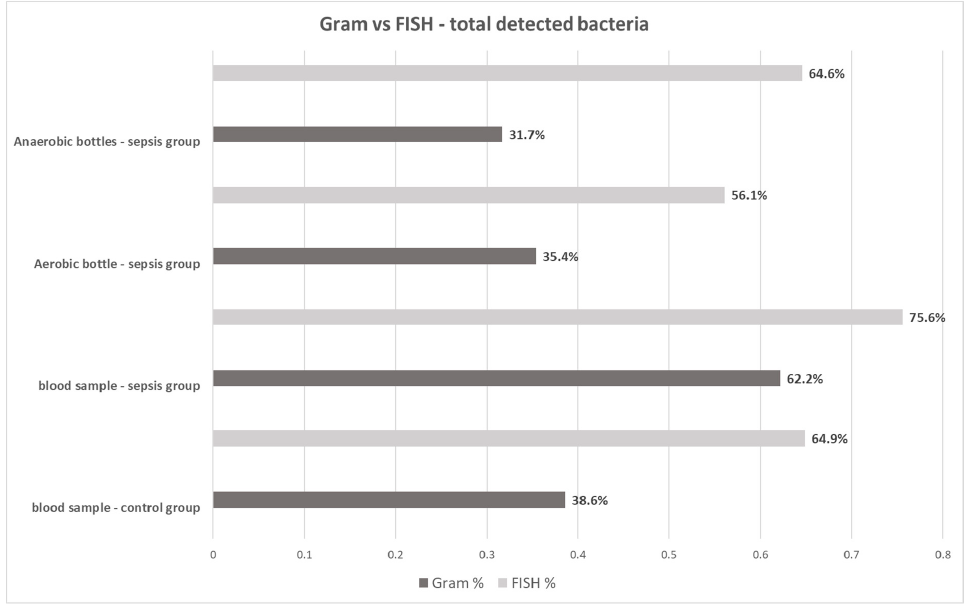
Figure 3. Total Gram stain and FISH results for blood samples, aerobic and anaerobic bottles in the group of patients with sepsis and for blood samples in the control group. Table 2. Quantitative comparison of positive and negative results obtained by Gram staining and FISH methods for blood samples, aerobic and anaerobic bottles in the group of patients with sepsis and for blood samples in the control group.